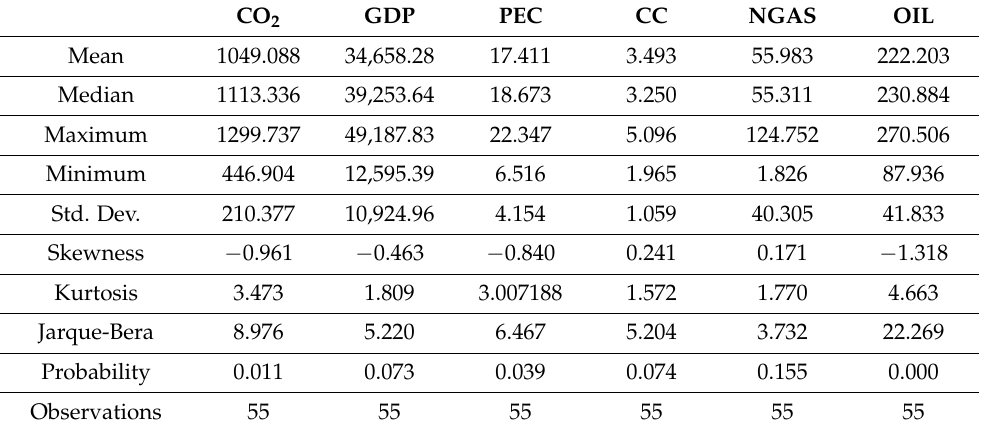
Table 2. Summary of the descriptive statistics.